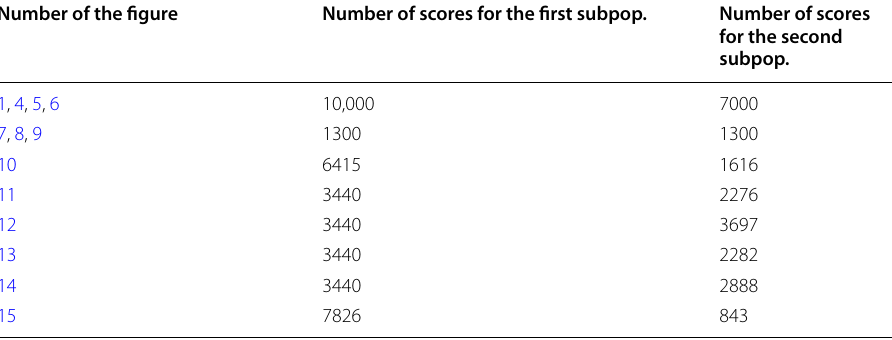
Table 2 Numbers of observations in the original data sets Number of the figure Number of scores for the first